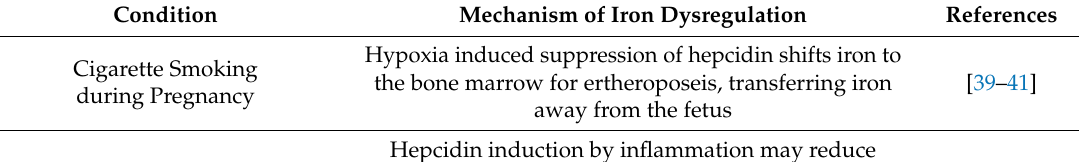
Table 1. Summary of iron related pathologies and therapeutics in Women’s